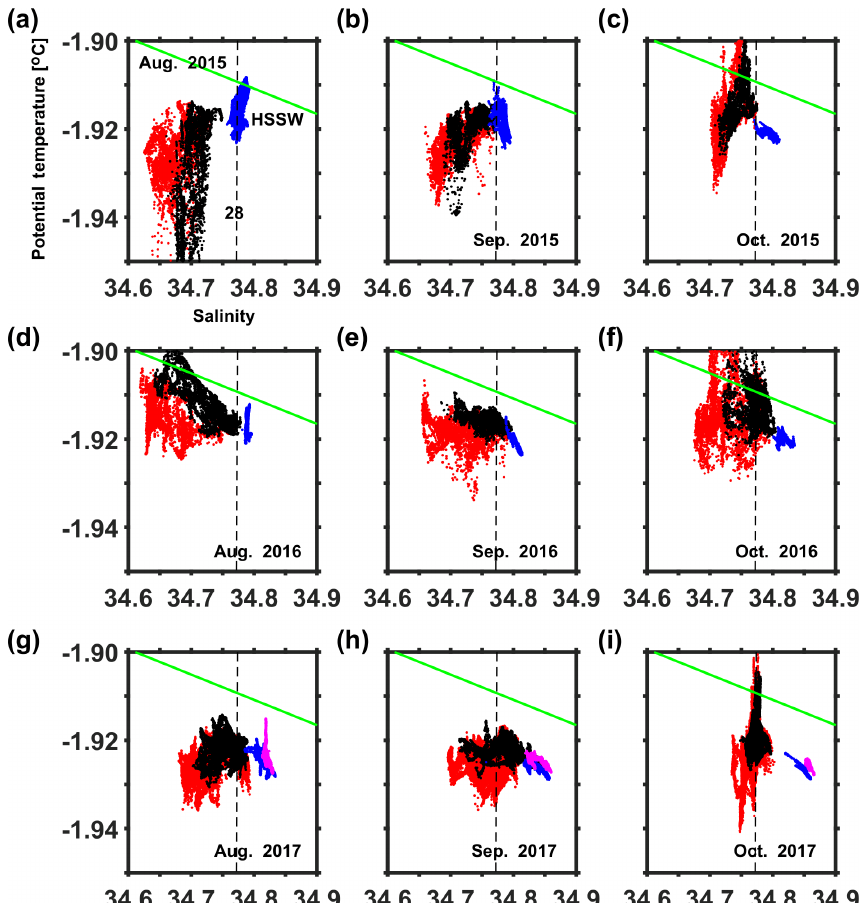
Figure 5. (a) A magnified version of the θ – S (potential temperature–salinity) diagram for data from the DITN and DITD in August 2015. Red, black, and blue dots are θ – S at 75, 273, and 660m, respectively. The thin green line denotes the freezing point at the surface depending on the salinity, while the black dashed line indicates σ θ = 28 . 00kgm − 3 . (b) The same as Fig. 5a, but for September 2015. (c) The same as Fig. 5a, but for October 2015. (d–f) The same as Fig. 5a–5c, but for August–October 2016. (g–i) The same as Fig. 5a–c, but for August– October 2017. Magenta dots are θ – S at